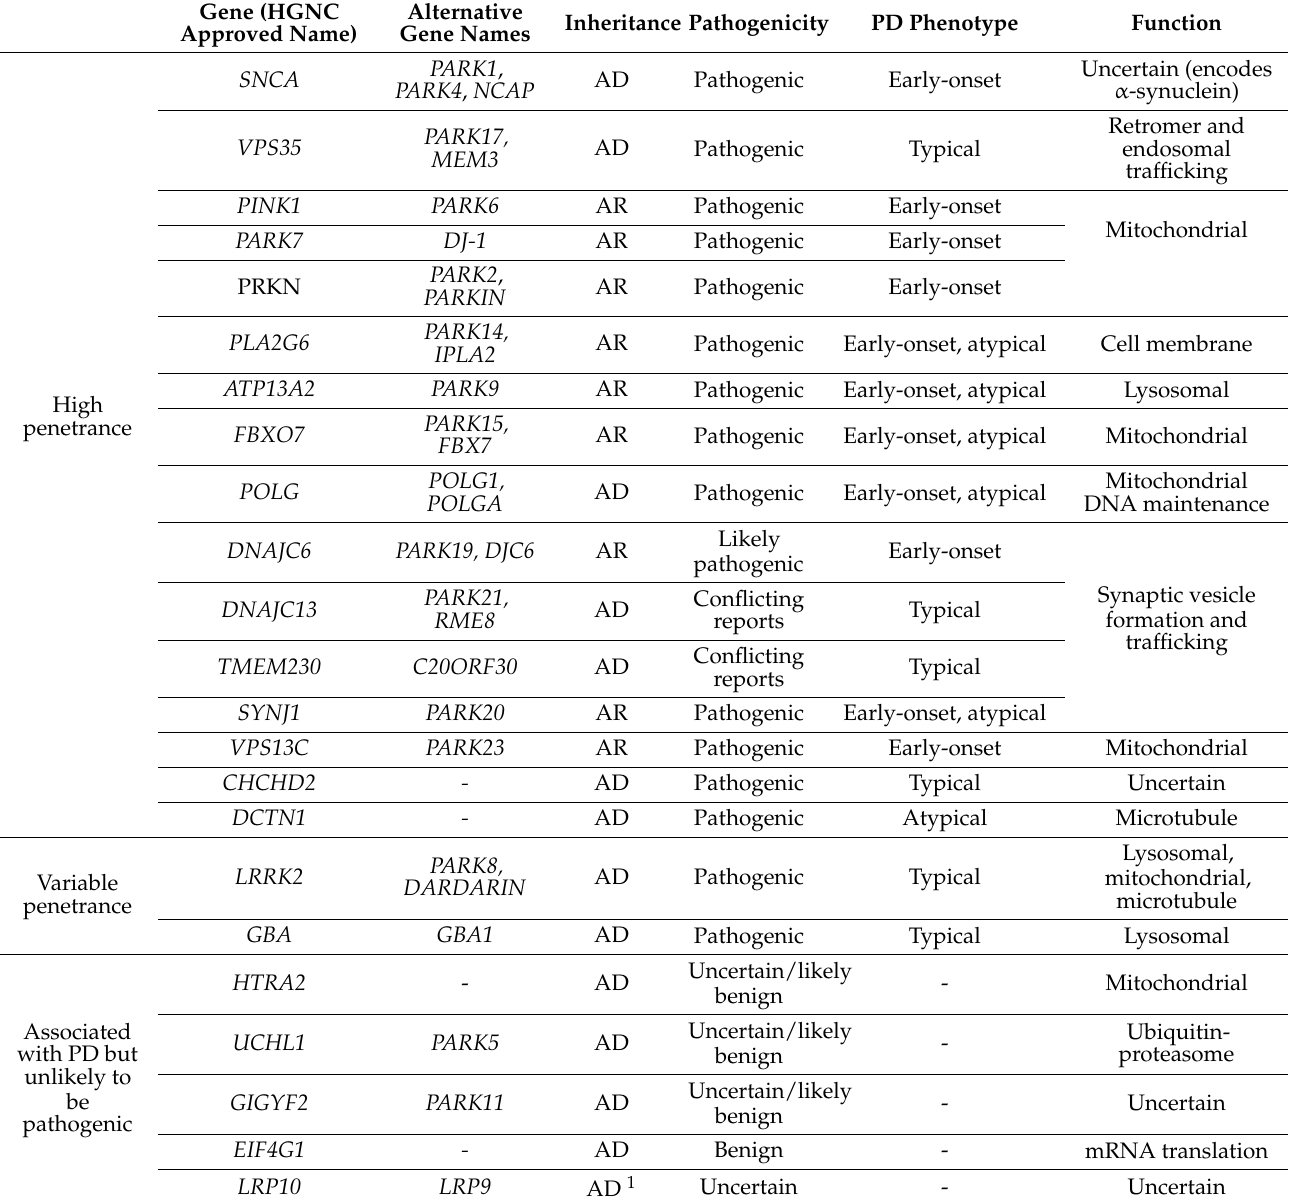
Table 1. Summary of monogenic variants associated with Parkinson’s